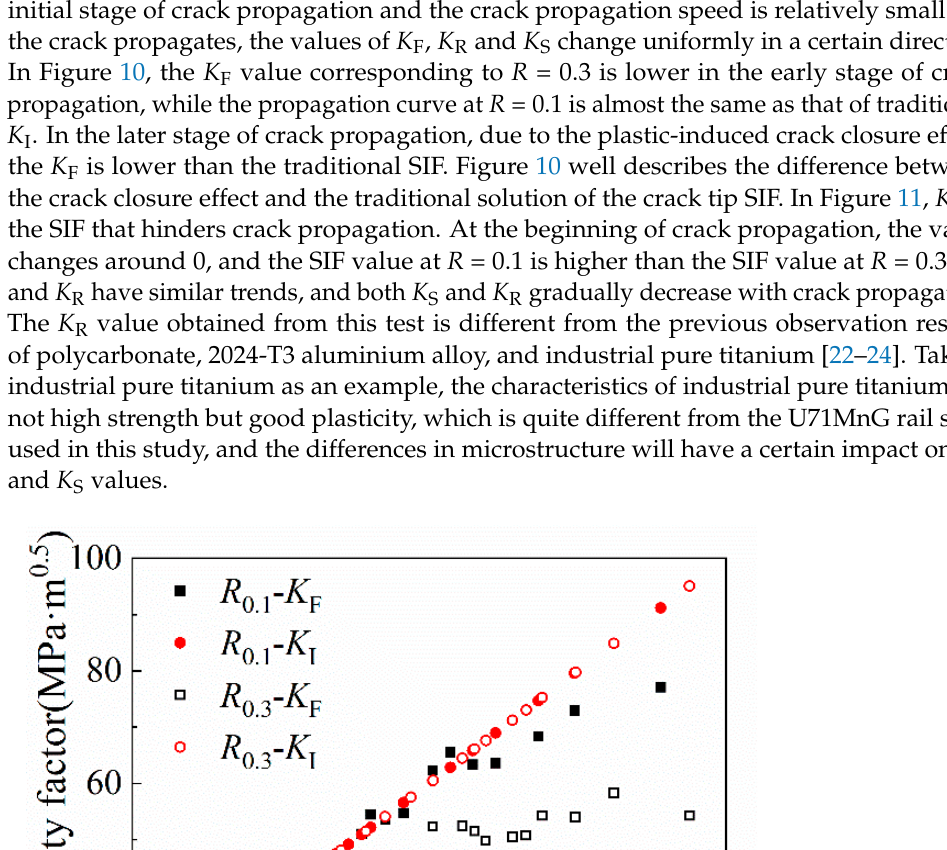
Figure 11. The variation of ( a ) SIF K R and ( b ) SIF K S with traditional SIF K I.